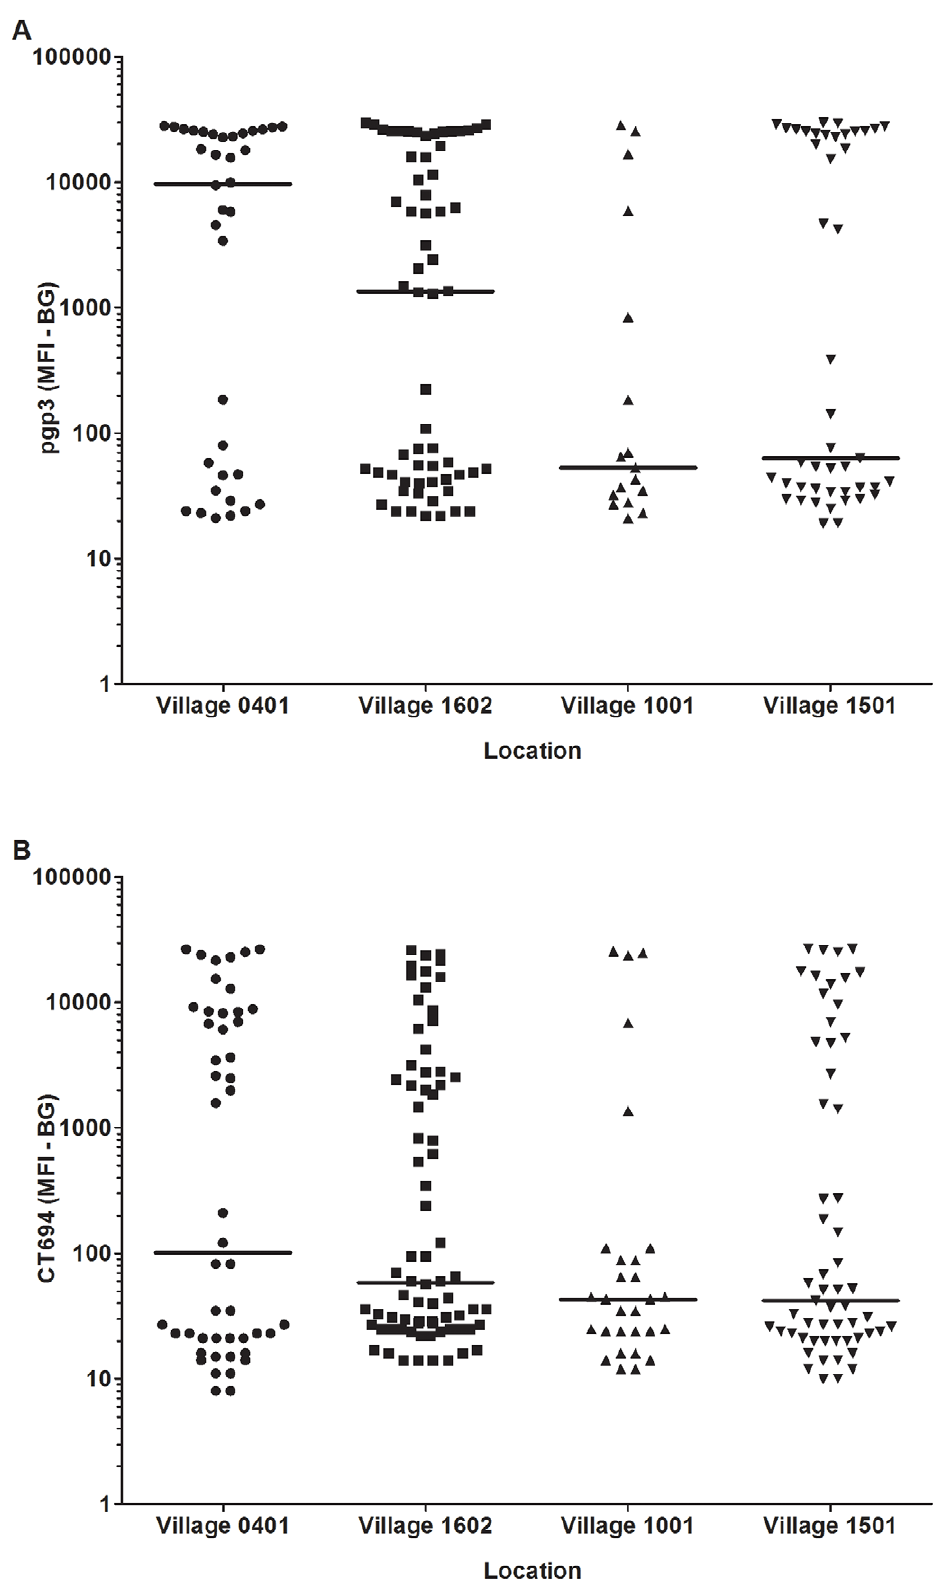
Figure 2. Antibody response to pgp3 and CT694 by village. Median responses are shown in median fluorescence intensity minus background (MFI-BG) by village for (A) pgp3 and (B) CT694.